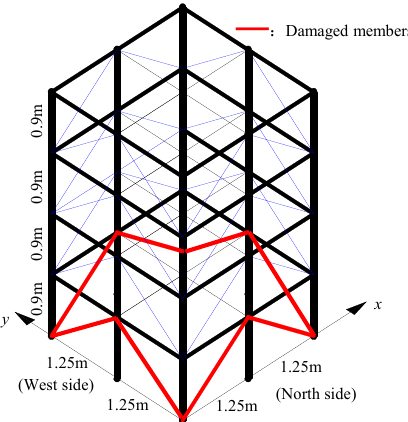
Figure 11. Custom damage of members.